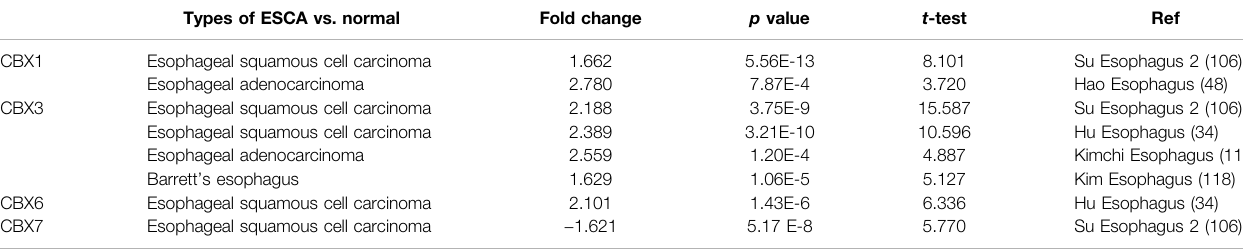
TABLE 1 | Signi fi cant changes of CBX expression in the transcription level between ESCA and normal esophagus tissues (ONCOMINE). Types of ESCA vs. normal